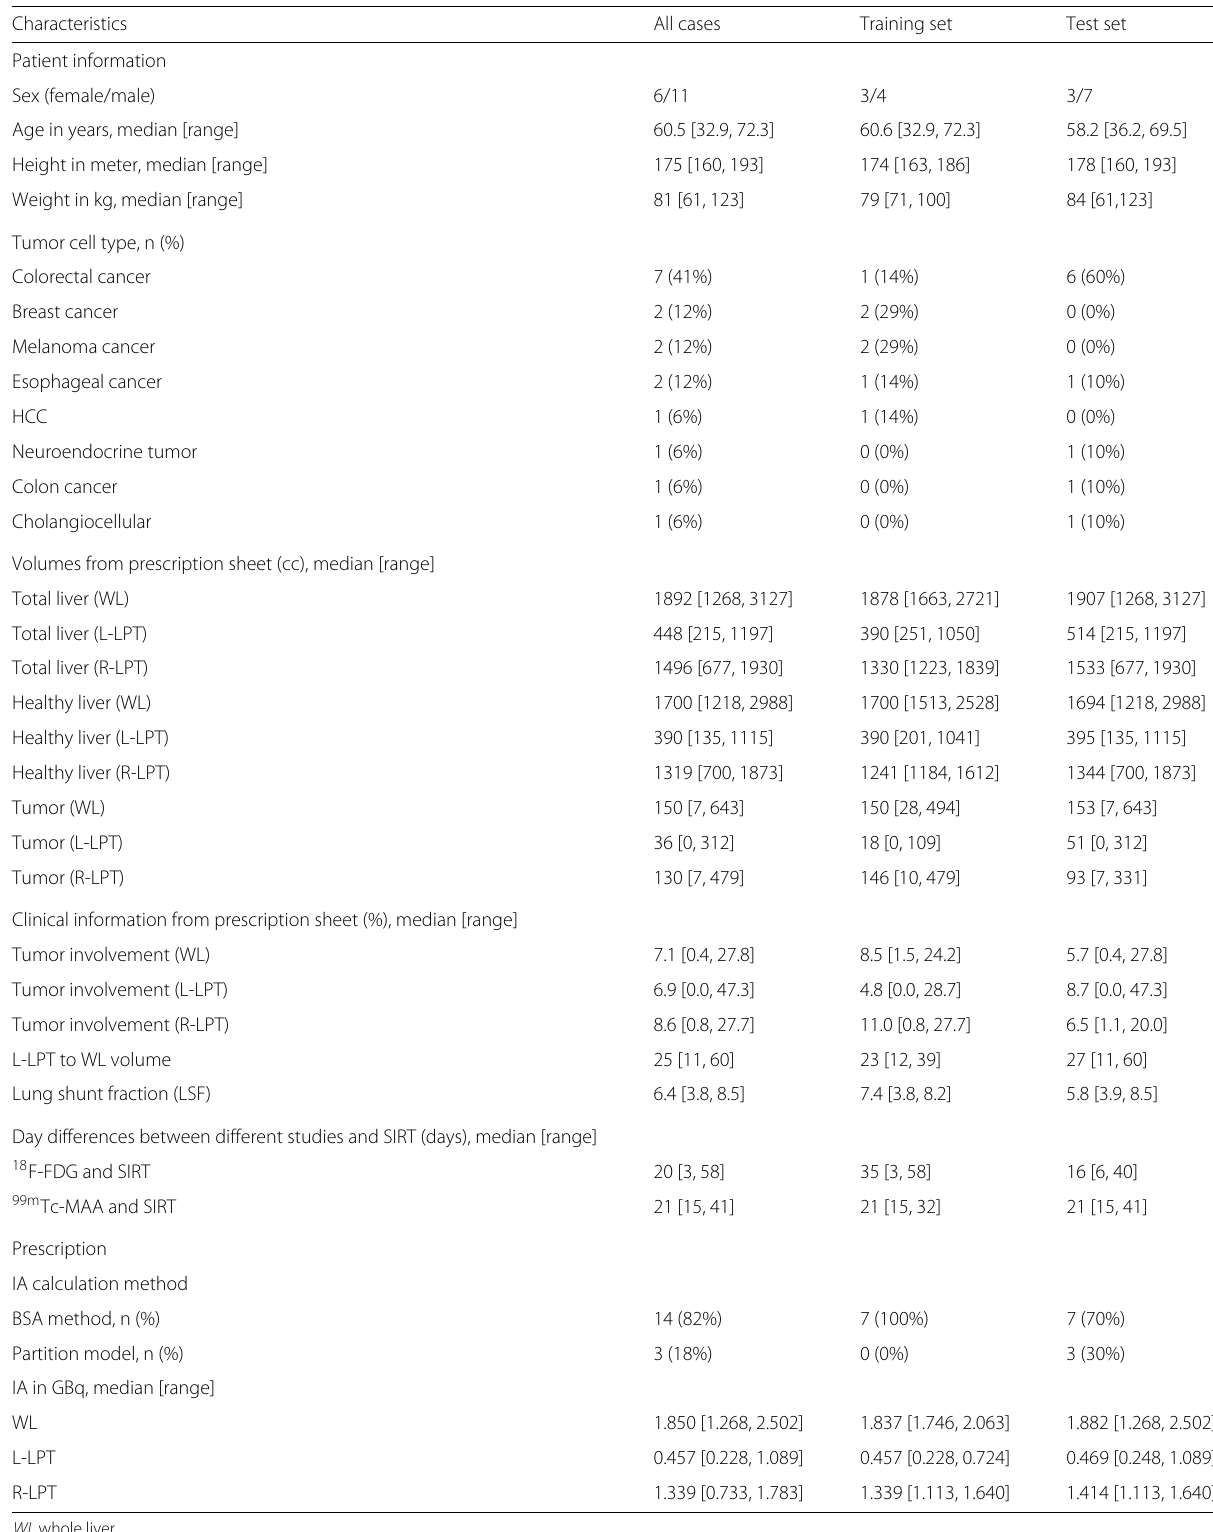
Table 4 Patient characteristics